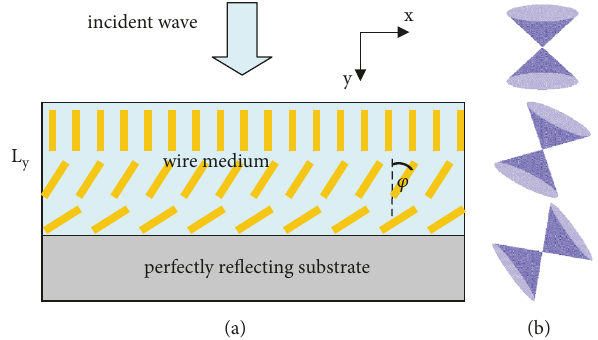
Figure 2: (Color online) (a) the geometry of the problem: the wire-medium slab with the thickness 𝐿 𝑦 is placed on the perfectly reflecting substrate. The components 𝜀 𝑥𝑥 , 𝜀 𝑦𝑦 , and 𝜀 𝑥𝑦 of the effective permittivity tensor depend on the orientation of the principal axes of the metamaterial, i.e., on the angle 𝜙 between the wires and the normal to the air-MM interface. In the slab of homogeneous metamaterial 𝜙 is fixed; however, we also consider the case of spatially changing orientation of the medium optical axis (see Figures 5–7). (b) Sketch of resonance cones orientation in inhomogeneous hyperbolic medium. The wave vector k of propagating radiation is located inside the resonance cone.